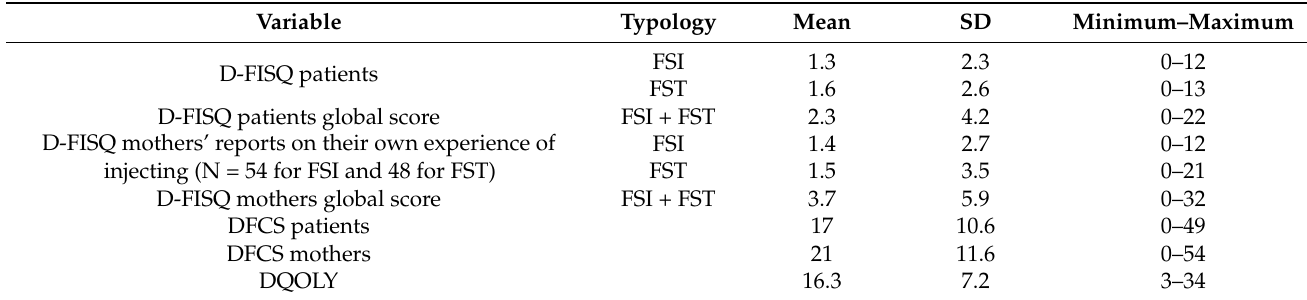
Table 3. Mean scores of fear of injecting, family conflicts and quality of life.